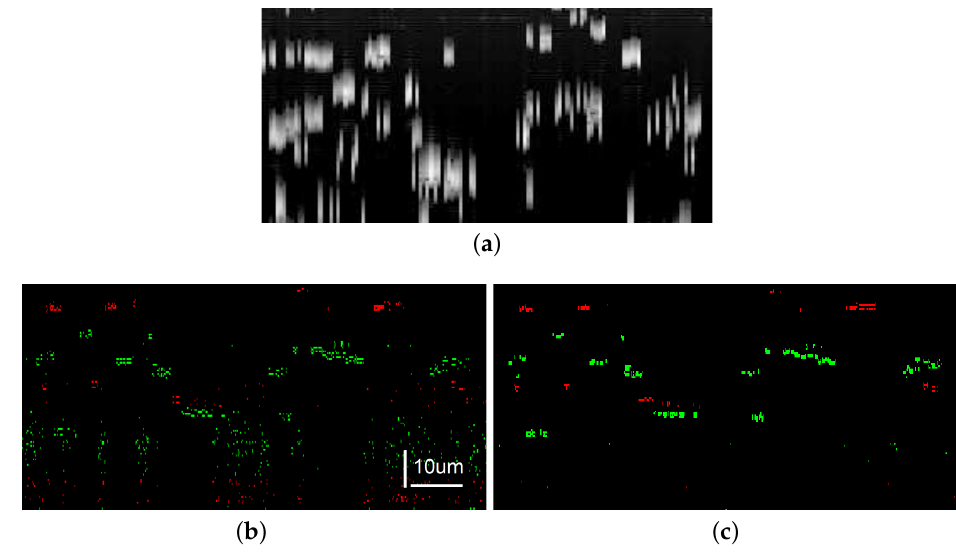
Figure 8. Cross-sectional images of the phantom sample obtained by the: ( a ) FD-OCT method; ( b ) short-time Fourier transform; and ( c ) the proposed method with short-time Fourier transform. Images are normalized and displayed in logarithmic